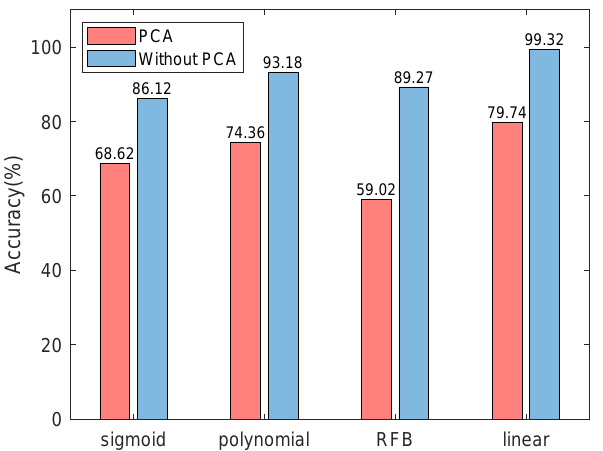
Figure 10. Accuracy comparison between using and not using